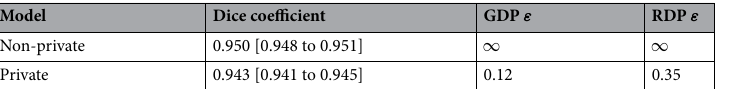
Table 2. Segmentation performance (measured by the mean Dice coefficient) on the liver semantic segmentation dataset. Ranges in angled brackets. The privately trained and the non-privately trained models performed on par despite the provision of stringent privacy guarantees in the privately trained setting.